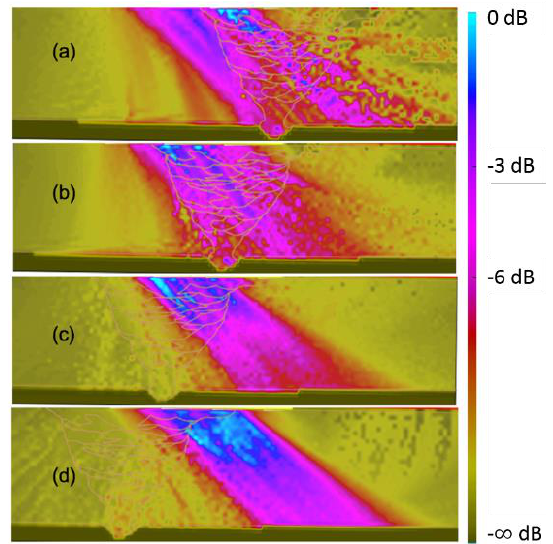
Figure 11. Longitudinal wave inspection. Scanning angle of 52 ◦ , with 16 elements. Indexes: ( a ) 3 mm, ( b ) 18 mm, ( c ) 32 mm and ( d ) 46 mm.